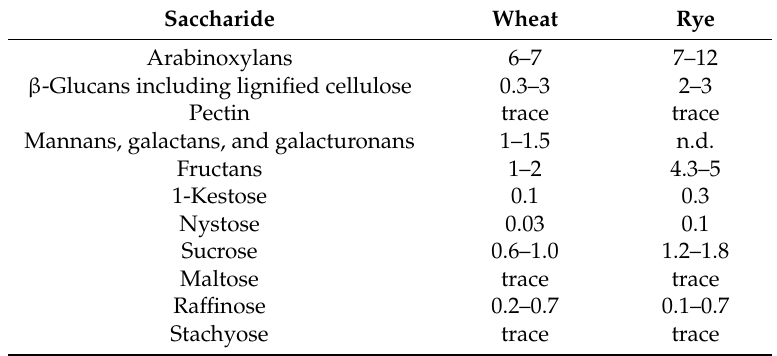
Table 1. Content of oligosaccharides and non-starch polysaccharides (%) in wheat and rye grains. Saccharide Wheat Rye Arabinoxylans 6–7 7–12 β -Glucans including lignified cellulose 0.3–3 2–3 Pectin trace trace Mannans, galactans, and